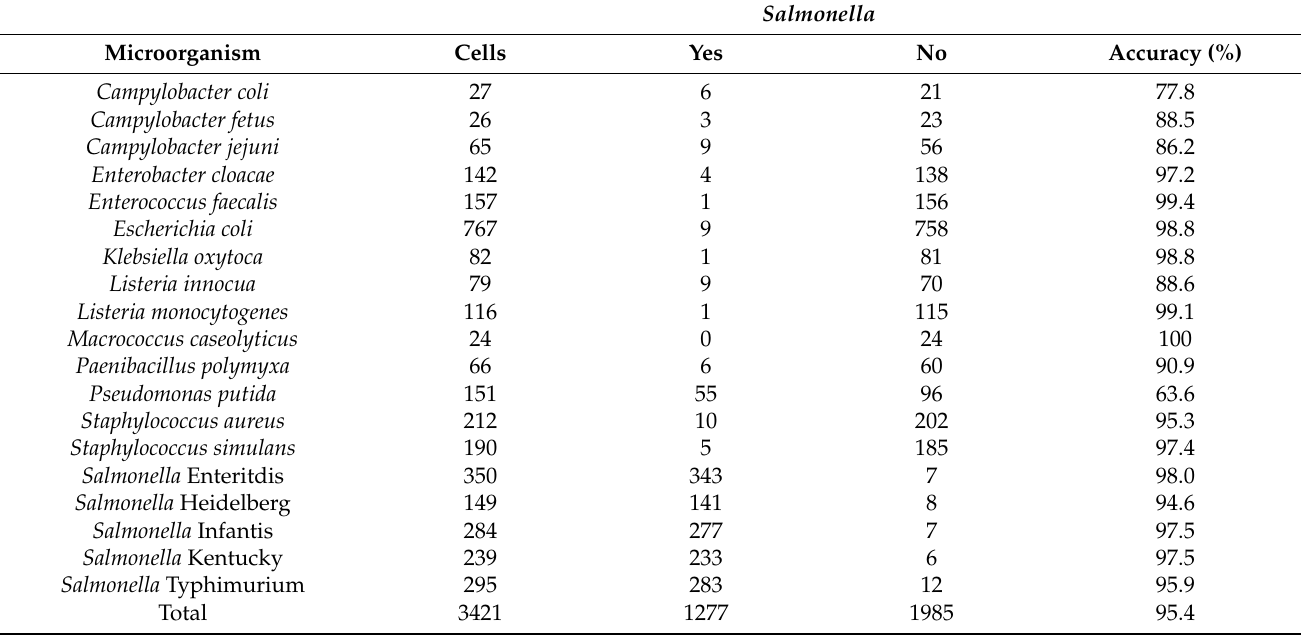
Figure 5. Soft-independent modelling of class analogy (SIMCA) calibration diagnostics: ( A ) PC scores 1 and 2, ( B ) loadings for PCs 1–4, ( C ) principal component analysis residuals, and ( D ) scree plot of explained variance (%). Table 3. SIMCA results for a one-class Salmonella prediction model obtained from hyperspectral microscope images of bacteria.